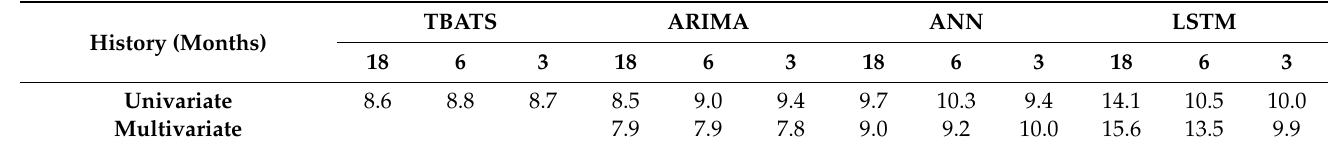
Table 7. Accuracy of one-step-ahead forecasting at the city scale.